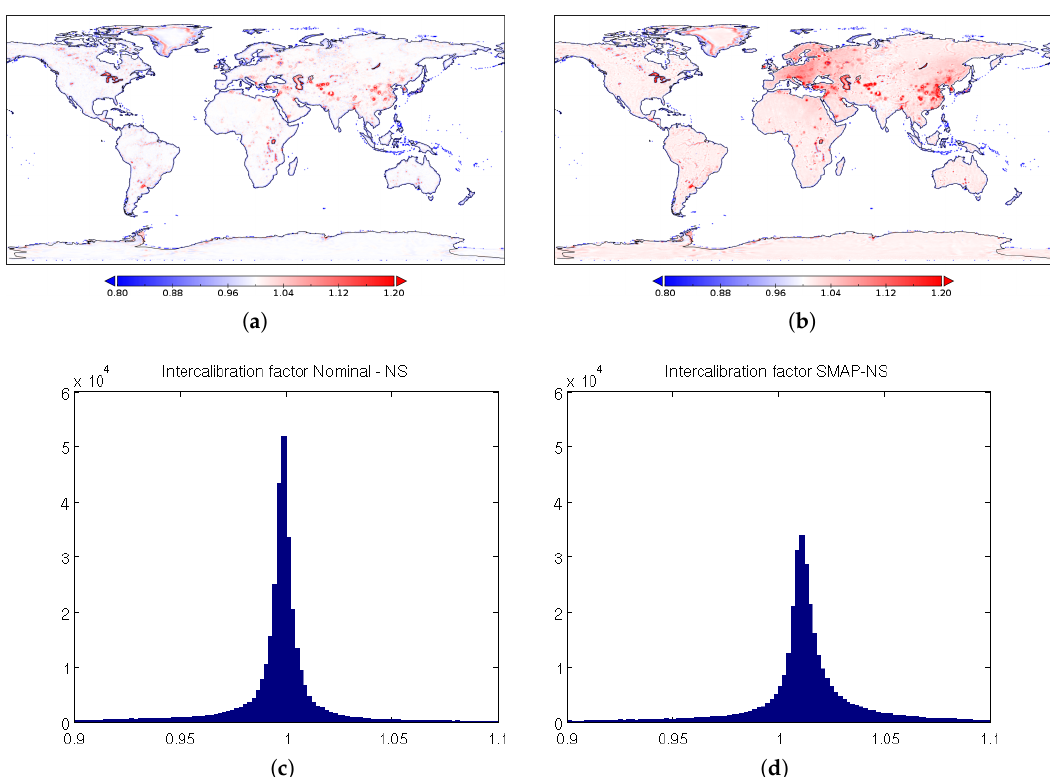
Figure 7. ( a ) Map of the intercalibration factor between SMOS nominal and SMOS NS ( α 12 ), ( b ) map of the intercalibration factor between SMOS NS and SMAP ( α 13 ), ( c ) histogram of α 12 , and ( d ) histogram of α 13